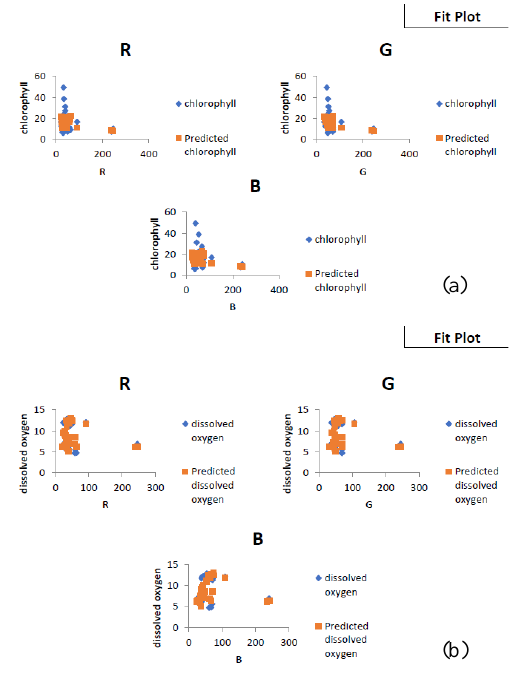
Figure 7 . Fit Plot (a) Chlorophyll and (b) Dissolved